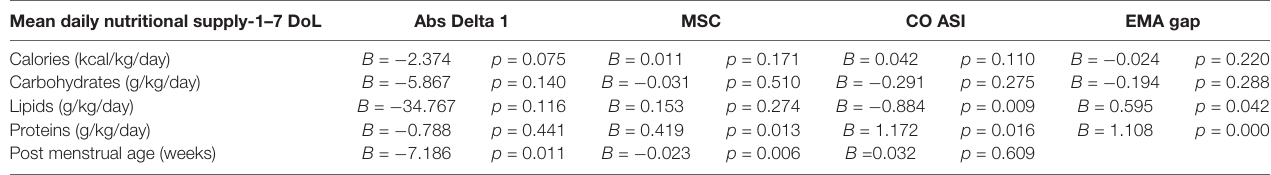
TABLE 2 | Generalized Estimation Equation model (GEE) to study associations between nutritional intake (mean daily intake) in the 1-week of life as a predictor for the changes in EEG